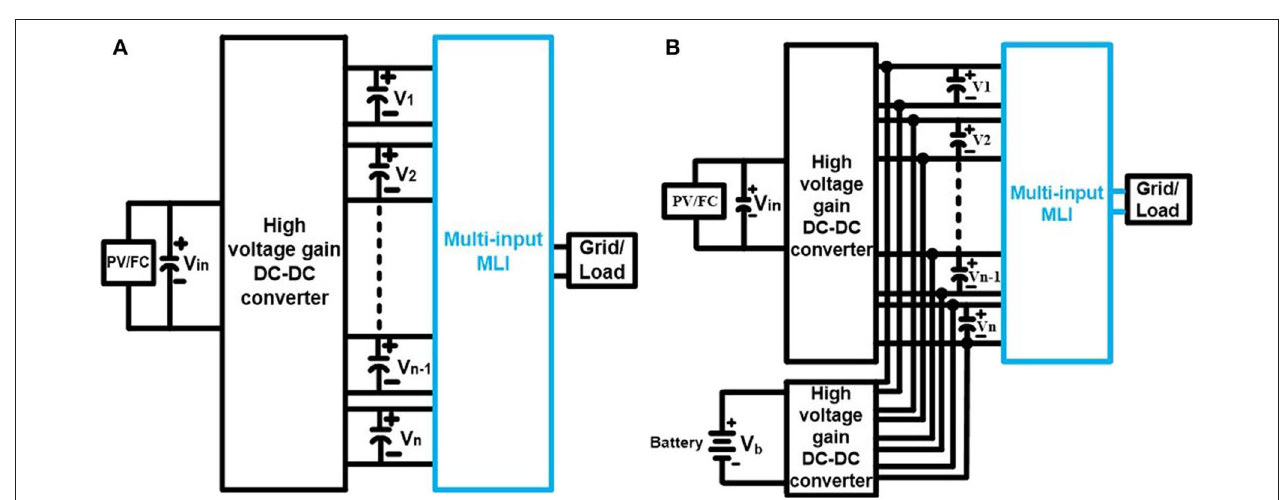
FIGURE 1 | The multi-input DC-AC converter based grid-connected PV/FC systems. (A) DC-DC converter fed Multi input MLI. (B) Battery supported DC-DC converter fed Multi input MLI.